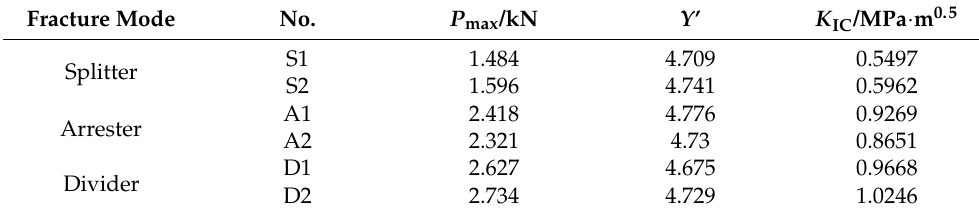
Table 4. Type-I fracture toughness determined by the NSCB test for three kinds of shale specimen.